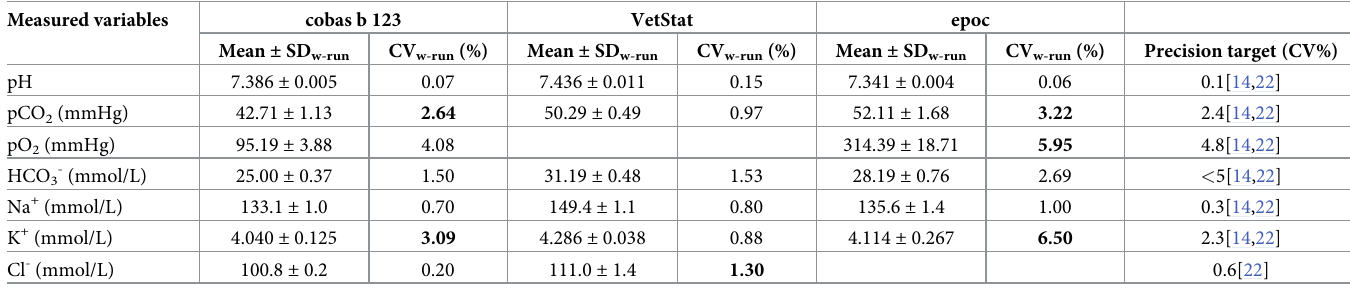
pCO 2 , partial pressure of carbon dioxide; pO 2 , partial pressure of oxygen; HCO 3- , bicarbonate; Na + , sodium; K + , potassium; Cl - , chloride. Values not meeting the precision targets are in